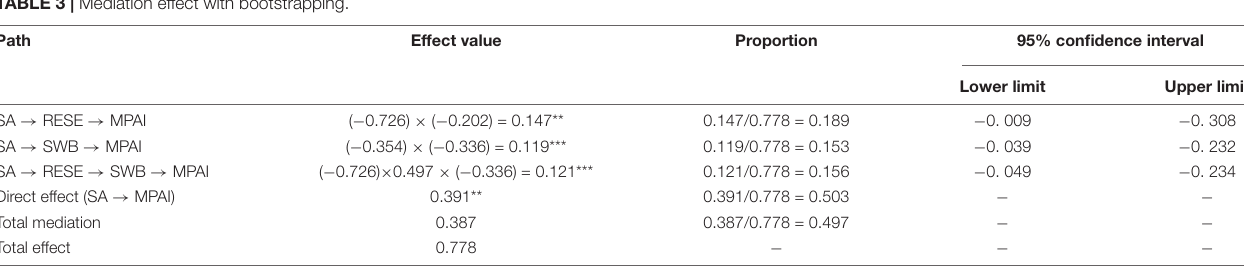
FIGURE 1 | Final standardized parameter values of the mode. SA, social anxiety; RESE, regulatory emotional self-efficacy; SWB, subjective well-being; MPAI, mobile phone addiction; TA, tension and anxiety; SIC , social interaction confidence; SIS, social interaction sensitivity; POS, positive affect; DES, despondency and distress; ANG, anger and irritation; PSY, psychological well-being; PHY, physical well-being; INT, interpersonal relationship well-being; UNC, uncontrolled addiction; ABS, abstinent addiction; AVO, avoidant addiction; INE, inefficient addiction. *** p < 0.001, ** p < 0.01. TABLE 3 | Mediation effect with